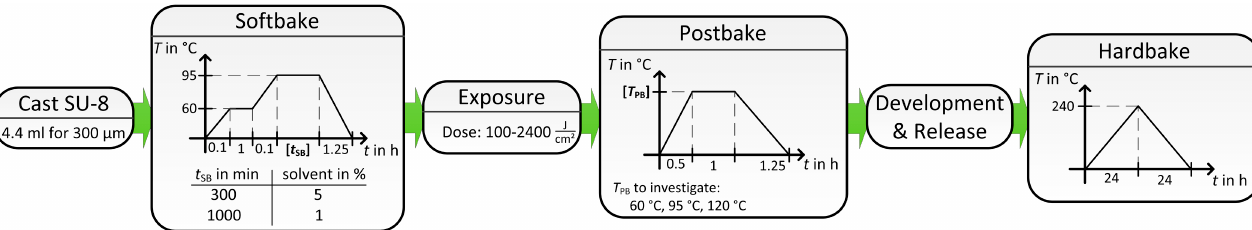
Figure 2. Fabrication steps of SU-8 with process parameters for